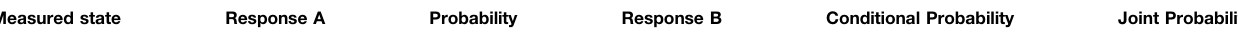
TABLE 2 | Probabilistic outcomes from the quantum circuit for a sequence of two queries A and then B. Measured